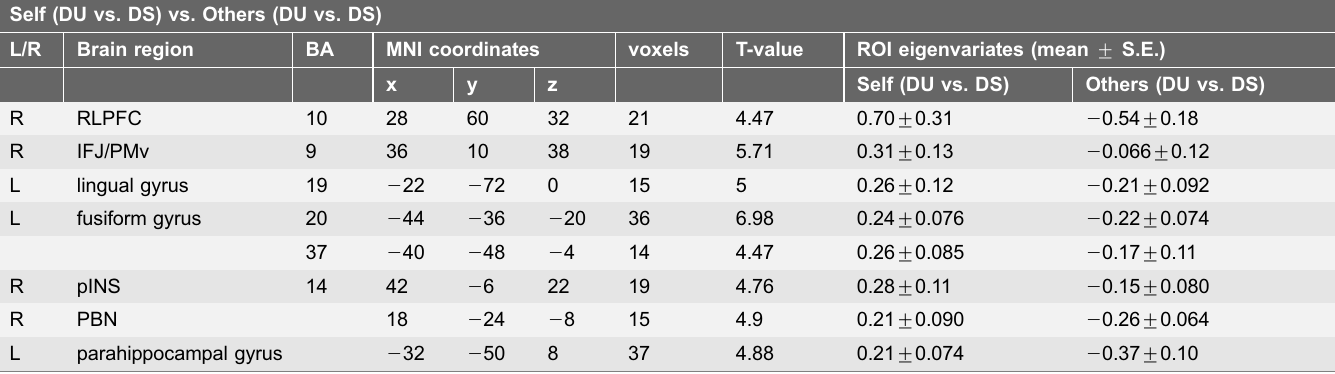
Table 3. Self-specific brain activity in the DU vs. DS contrast. Self (DU vs. DS) vs. Others (DU vs.